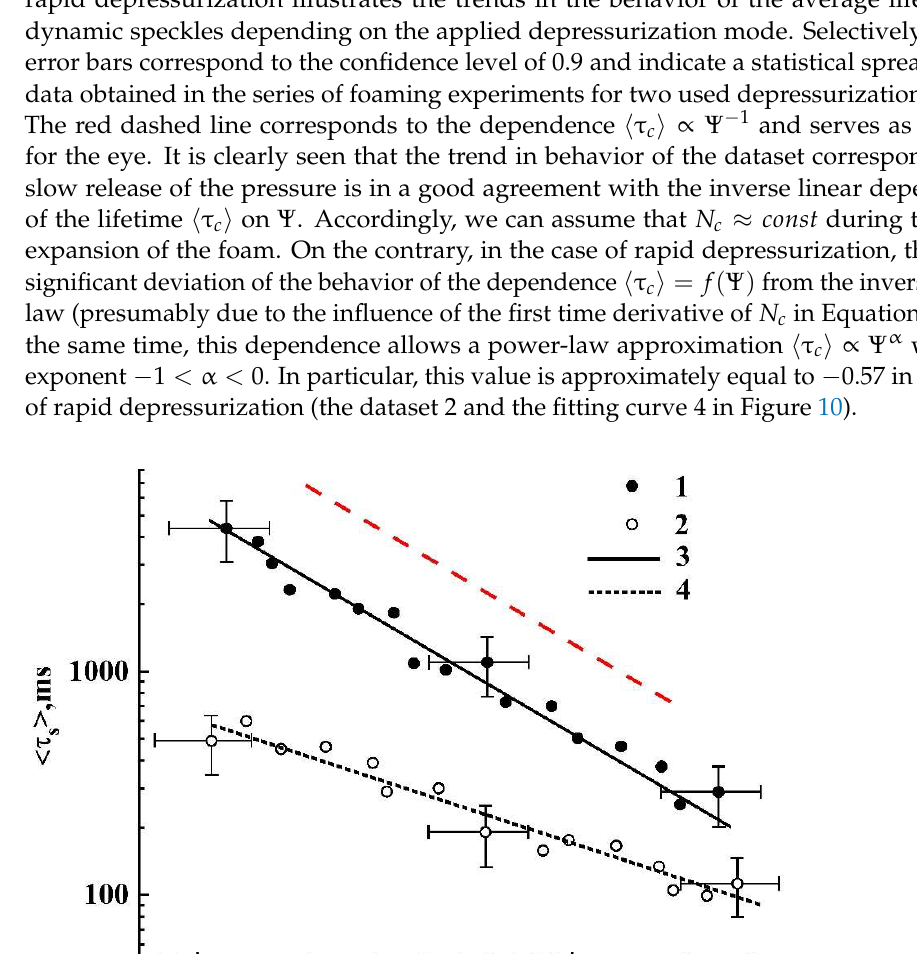
Figure 10 displaying the values of (cid:104) τ s (cid:105) against Ψ for the examined cases of slow and